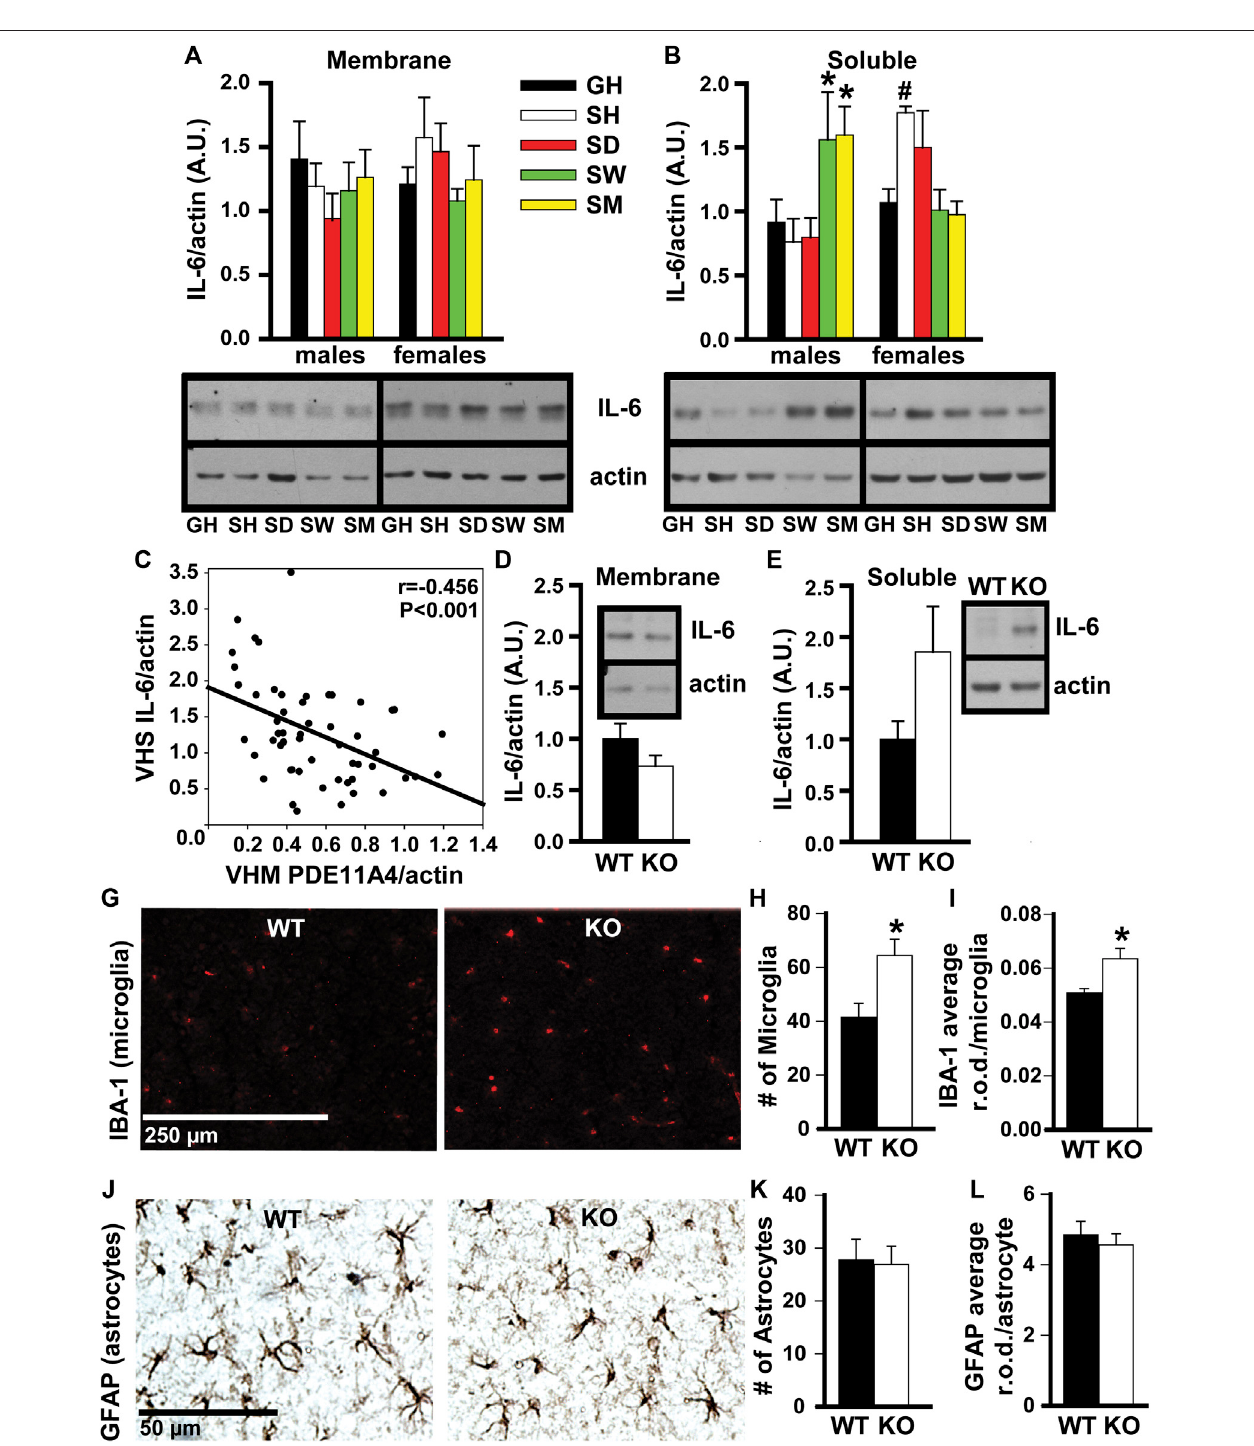
FIGURE 4 | In adult mice, social isolation and decreased PDE11A4 signaling upregulate markers associated with neuroin fl ammation. Previous studies comparing expression ofPDE11Aand thecytokineinterleukin-6(IL-6)betweenmousestrainsdetermined lower expressionofPDE11A4 inventral hippocampal membranes(VHM) correlated with higher expression of IL-6 in ventral hippocampal the soluble fractions (VHS) (Pathak et al., 2017). (A) Similarly, western blots of ventral hippocampal fractionsfromadultgrouphousedmice(GH)versusadultmicesingle-housedfor1 h(SH),1day(SD),1week(SW),or1month(SM)showthatsocialisolationdoes not signi fi cantly affect IL-6 expression in the membrane compartment of the VHIPP (n (cid:2) 7 – 8/group/sex; effect of group x sex: F (4,55) (cid:2) 1.58, P (cid:2) 0.192), (B) but does increase IL-6 expression in the soluble fraction, albeit at different time points for each sex (n (cid:2) 7 – 8/group/sex; effectof group x sex: F (4,51) (cid:2) 6.52, p < 0.001; Post hoc :